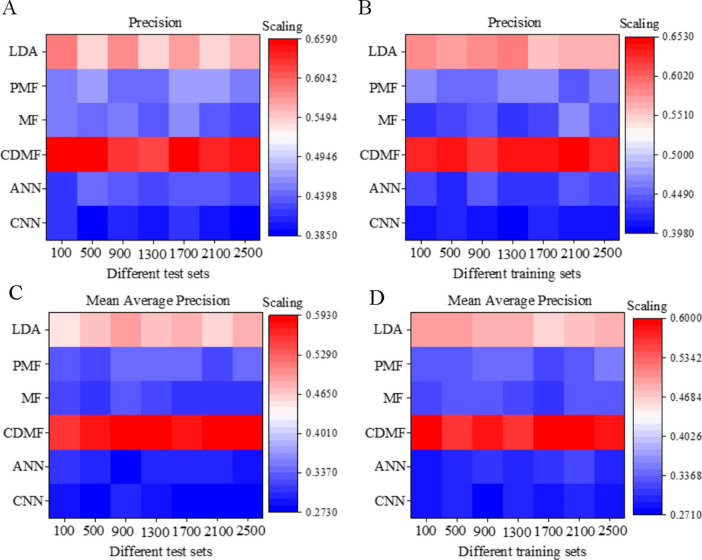
Performance analysis of pre and MAP of different models.